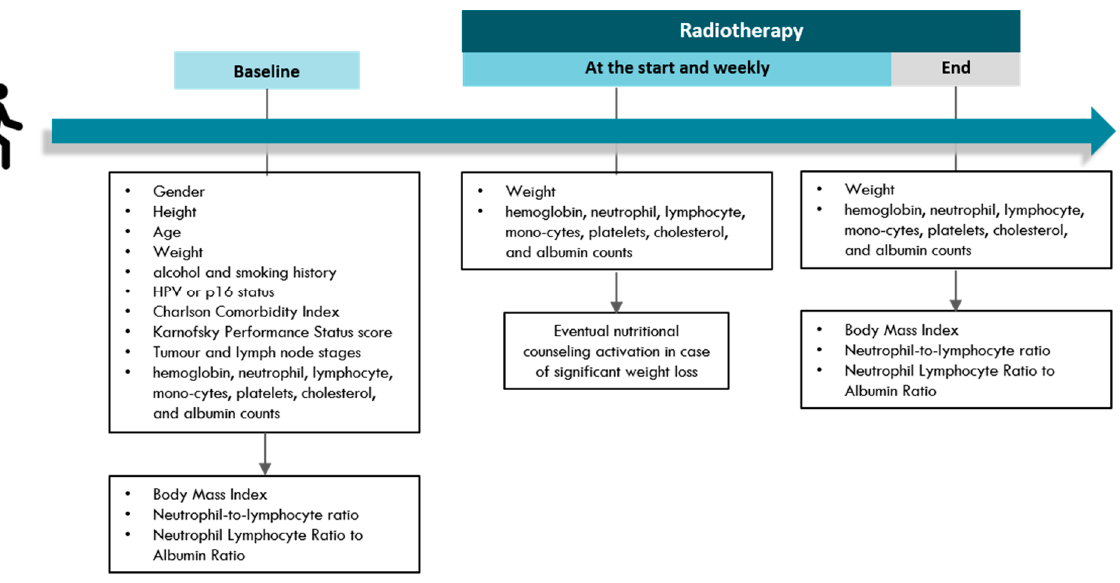
Figure 1. Summary of collected clinical parameters at time points of interest. Tumor and lymph node stages were defined according to the 7th edition of the can Joint Committee on Cancer/Union for International Cancer Control (AJCC/IUCC).